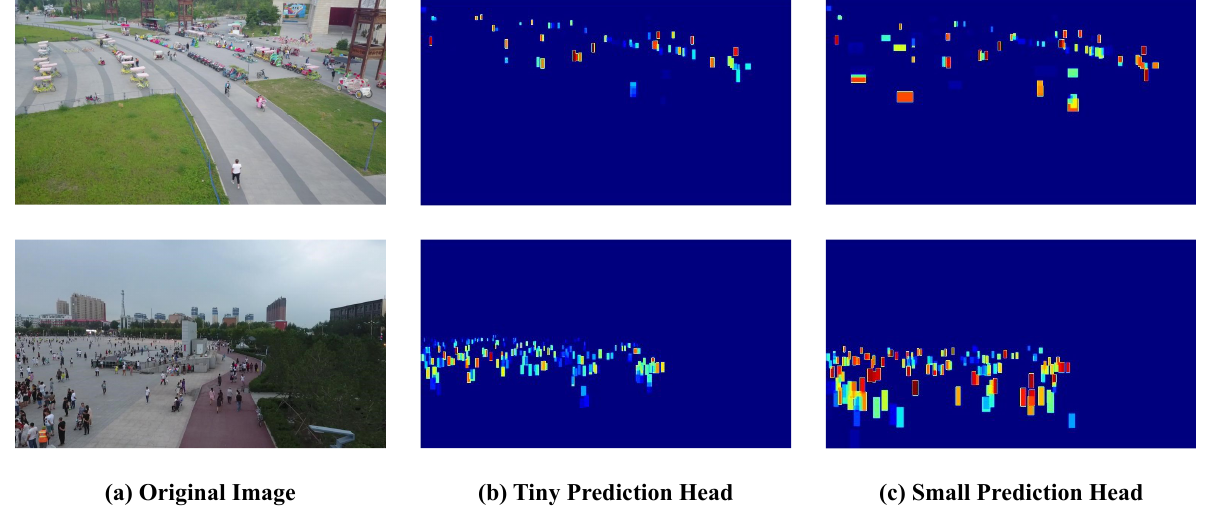
Figure 5. Two cases of spatial distributions of correct bounding boxes generated by tiny and small heads. The color of each pixel denotes the average confidence of correct boxes covering the pixel. If the confidence is high, the color tends towards red, otherwise it tends towards